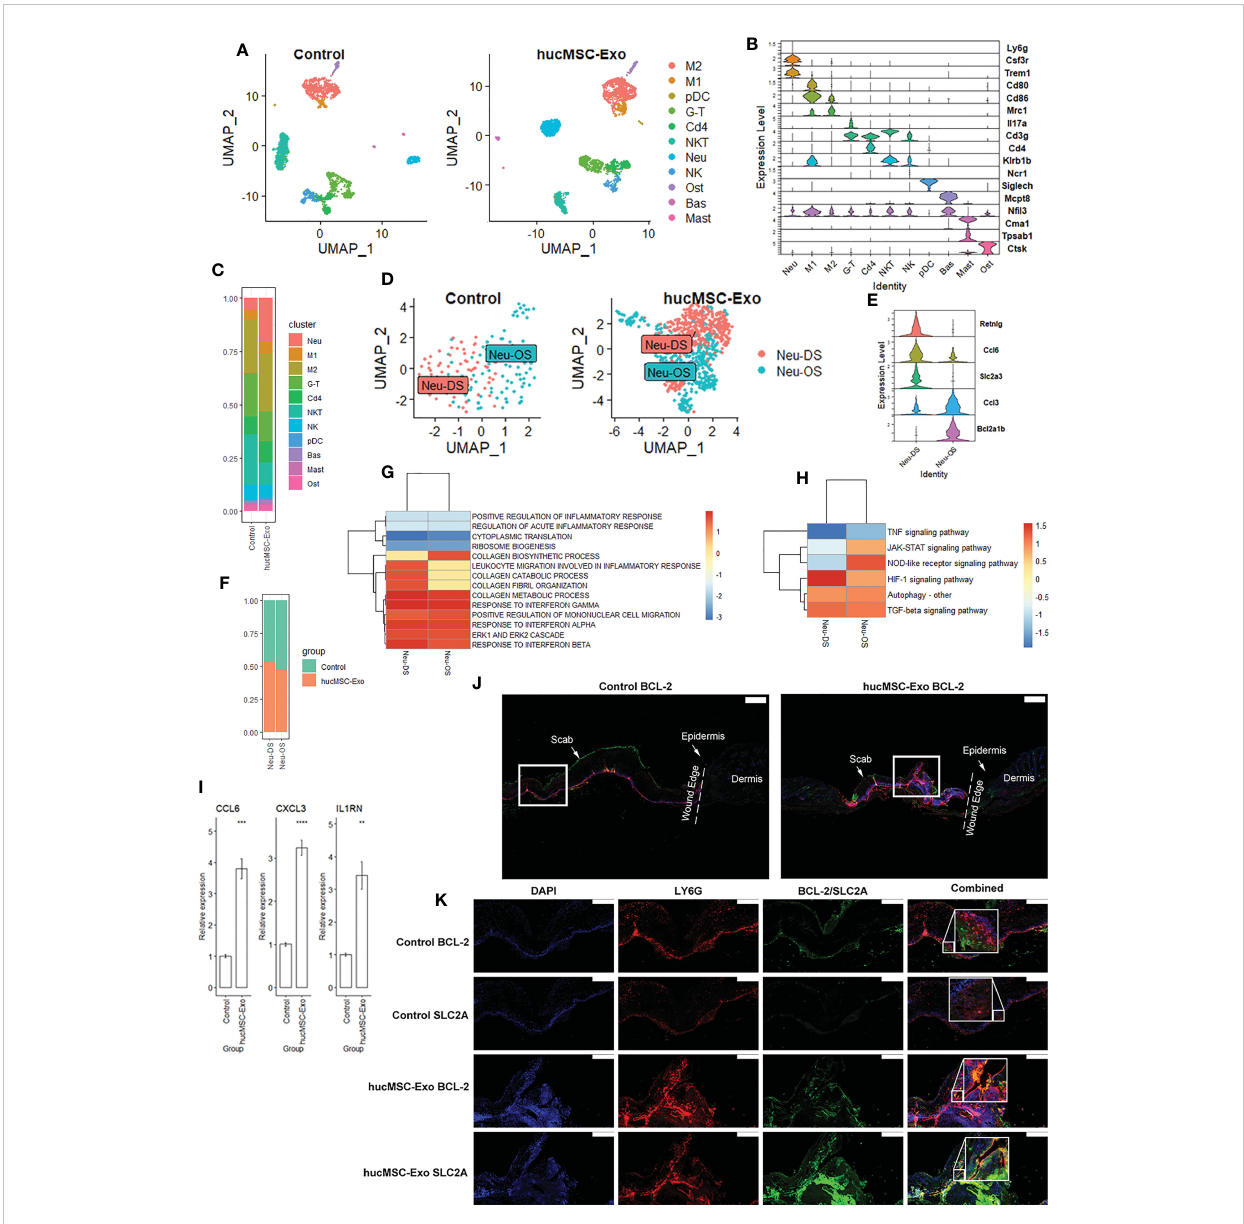
FIGURE 2 HucMSC-Exosomes induce functional changes in neutrophils. (A) 2D scatterplot based on UMAP reduction of immune cell coordinates. (B) Stacked violin plot of immune cell annotation markers. (C) Stacked bar plot of immune cell abundance ratio. (D) 2D scatterplot based on UMAP reduction of neutrophil coordinates. (E) Stacked violin plot of neutrophil subcluster annotation markers (F) Stacked bar plot of neutrophil subcluster abundance ratio. (G) GSEA Heatmap of neutrophil differentially expressed genes (DEGs) following hucMSC-Exosomes exposure (H) KEGG Heatmap of neutrophil DEGs following hucMSC-Exosomes exposure. (I) Quantitative RT-PCR analysis of the Ccl6 , Cxcl3 , and Il1rn mRNA expressions in peri- wound samples. Two-tailed unpaired t-test (n = 6). Error bar: mean standard error. GAPDH was used as the reference gene. **p < 0.01, ***p < 0.001, ****p < 0.0001. (J) Merged immuno fl uorescence staining with BCL-2 (green), LY6G antibody (red) and nuclear staining (DAPI). The scale bar is 500 µm. White square indicate the region of (K) . (K) Immuno fl uorescence staining with BCL-2 or SLC2A antibody (green) and LY6G antibody (red). Nuclear staining (DAPI) and merged images are also shown in the diagram. The scale bar is 200